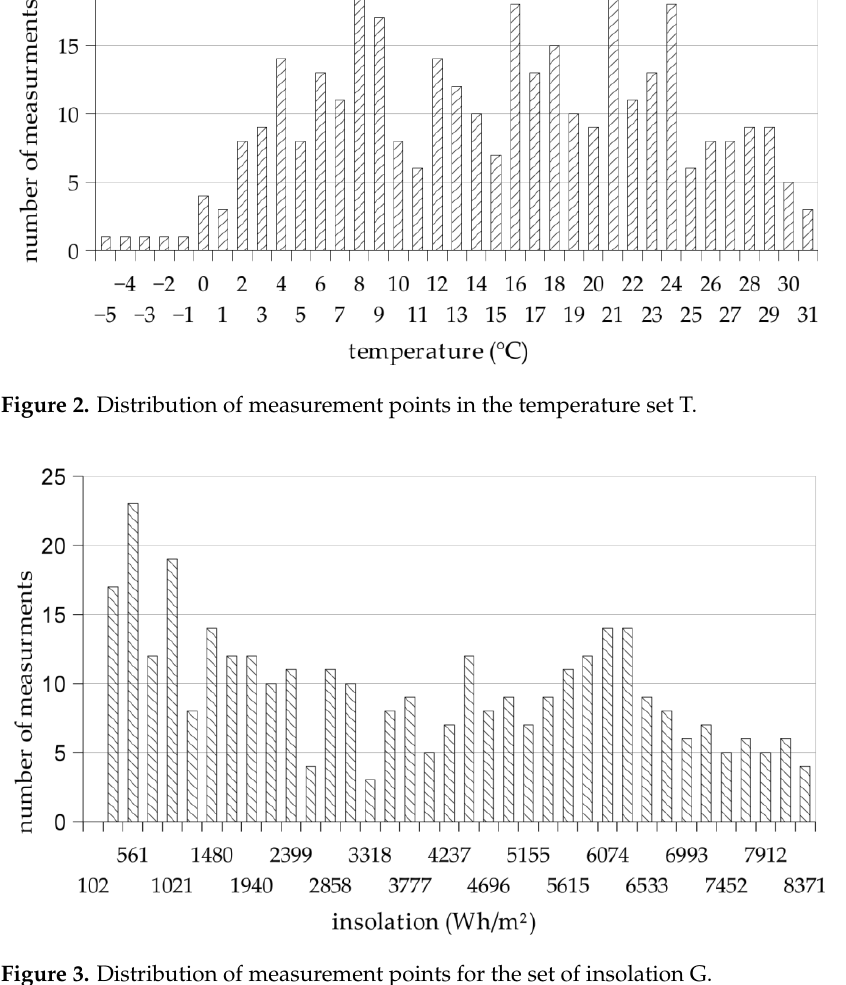
Figure 3. Distribution of measurement points for the set of insolation G.